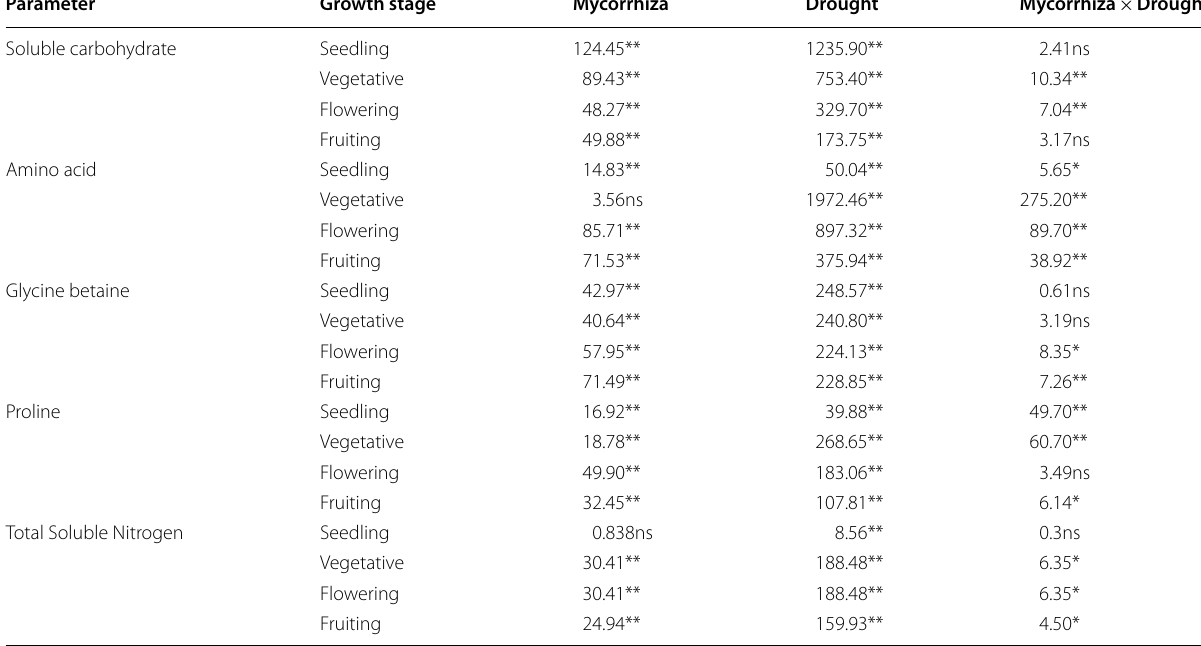
** P < 0.01; * P < 0.05; ns, non‑ significant